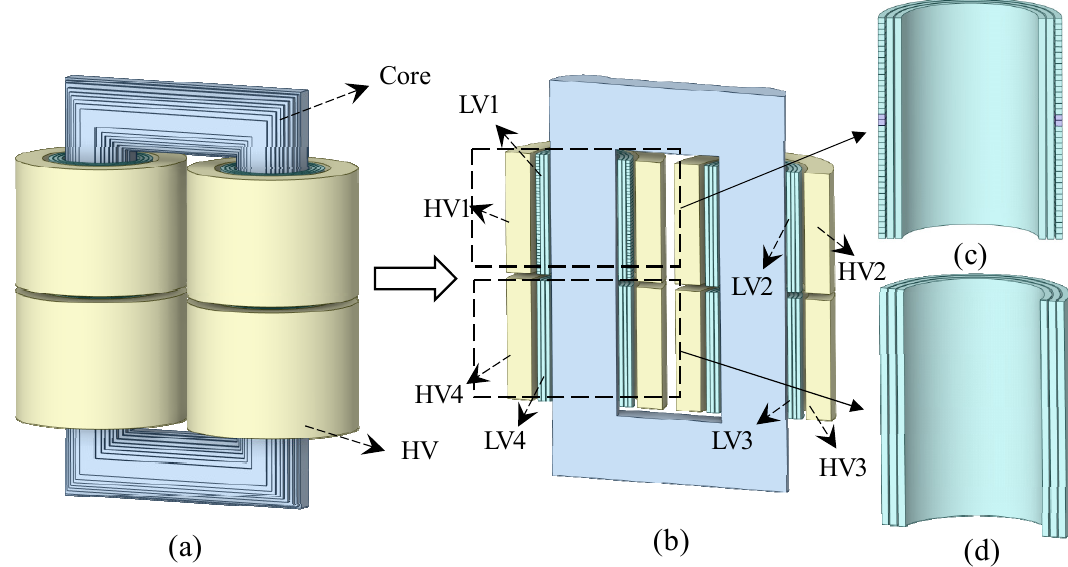
Figure 1. Establishment of simulation model. ( a ) Original simplification model. ( b ) Improved simplification model. ( c ) Simplified form of winding with TTF. ( d ) Simplified form of winding without TTF.